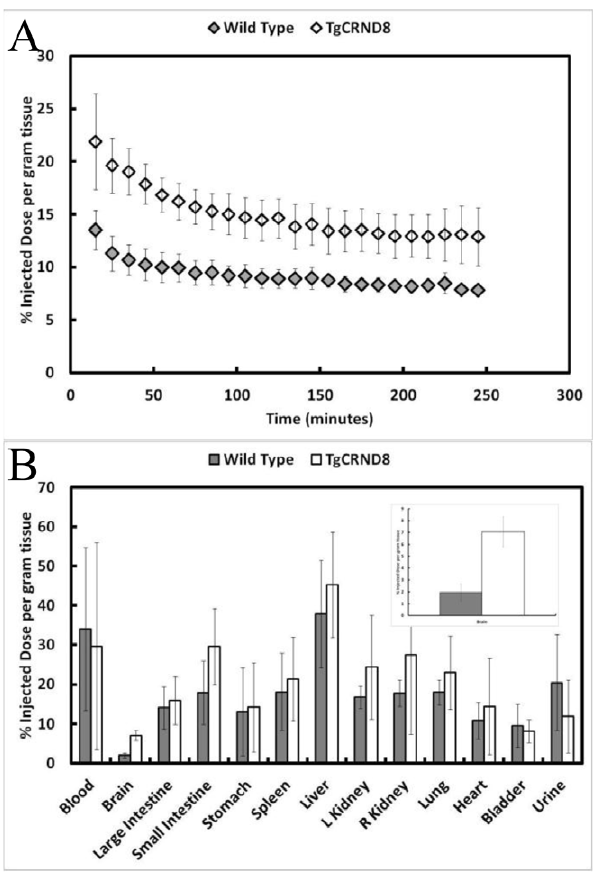
Figure 4. Examination of brain tissue post-mortem confirms higher accumulation of intravenously injected 6E10- 64 Cu in TgCRND8 than wild type mice. (A) Post-mortem biodistribution analysis of all organs 12 h after intravenous injection does not distinguish between TgCRND8 and wild type brain tissue, but does reveal accumulation and removal in liver, kidneys, and gastrointestinal organs (n=3, mean 6 standard deviation plotted). (B) Ratio of % injected dose per gram of tissue TgCRND8 to wild type brain tissue, as measured by gamma counting and PET quantitation, confirms higher accumulation in TgCRND8 than wild type mice 2 h after injection with 6E10-PEG. (n=3, mean 6 standard deviation plotted).